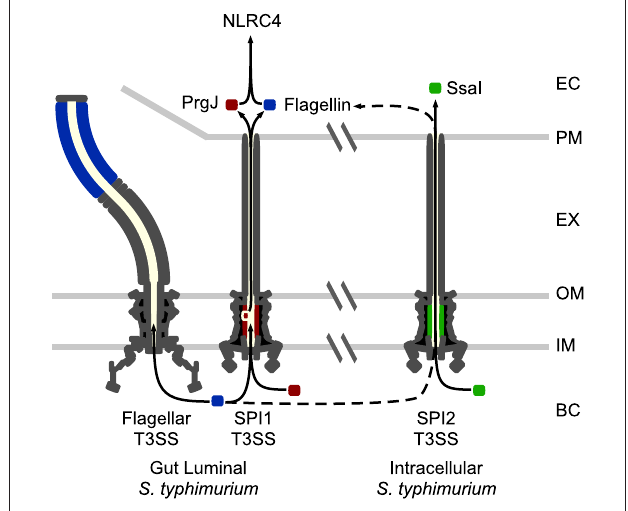
FIgure 2 | NLrC4 detection of S. typhimurium . There are two major phases of S. typhimurium growth, extracellular in the gut lumen (modeled on the left), and intracellular within macrophages and epithelial cells (modeled on the right). While SPI1 and flagella are expressed in the gut lumen, SPI2 is expressed in the intracellular compartment. Inadvertent translocation of flagellin (blue) or the SPI1 T3SS rod protein, PrgJ (red), is detected by NLRC4, while the SPI2 rod, SsaI (green), is not detected. NLRC4 can detect intracellular adapted S. typhimurium via flagellin transfer through the SPI2 T3SS, albeit much less efficiently than gut adapted bacteria. EC: eukaryotic cytosol. PM: eukaryotic cell plasma membrane. EX: extracellular space. OM: bacterial outer membrane. IM: bacterial inner membranel. BC: